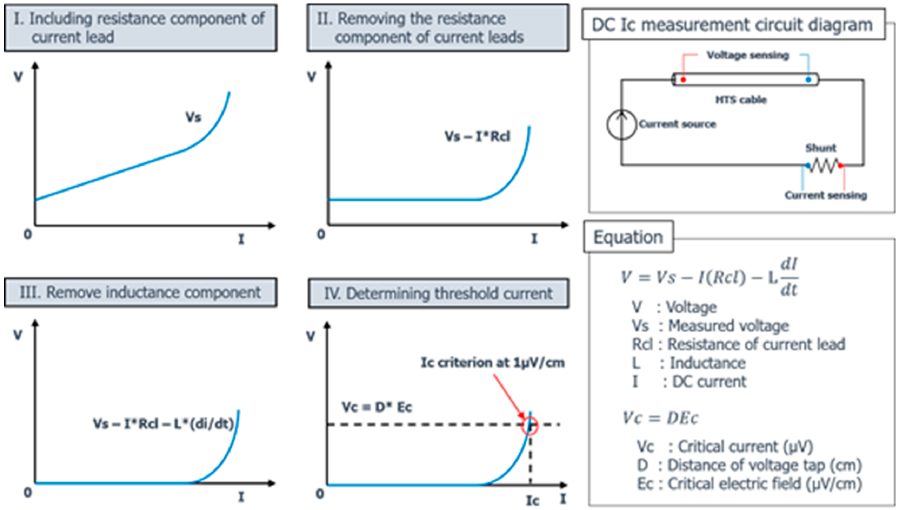
Figure 8. Algorithm of the DC-critical current measurement.